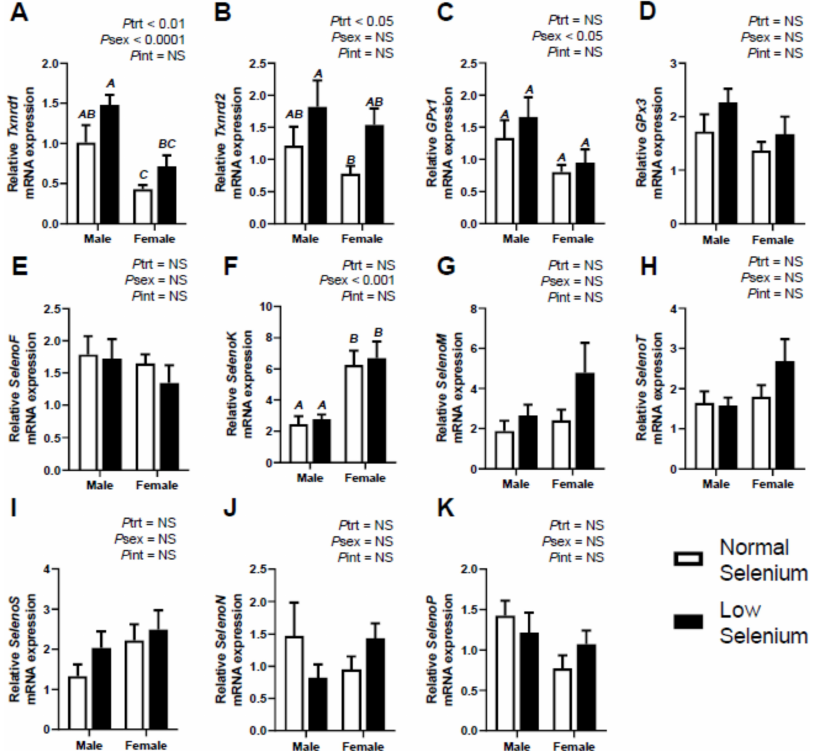
Figure 5. E ff ects of selenium deficiency on selenoprotein expression in o ff spring kidneys at PN180. Expression in male and female o ff spring kidneys, at PN180, of; ( A ) thioredoxin reductase 1, ( B ) thioredoxin reductase 2, ( C ) glutathione peroxidase 1, ( D ) glutathione peroxidase 3, ( E ) selenoprotein F, ( F ) selenoprotein K, ( G ) selenoprotein M, ( H ) selenoprotein T, ( I ) selenoprotein S, ( J ) selenoprotein N and ( K ) selenoprotein P. Data are mean ± SEM and analysed by two-way ANOVA with treatment ( P trt ) and sex ( P sex ) as major factors. P int represents the interaction between treatment and sex. Significance was determined as p < 0.05. If a major effect of treatment, sex or an interaction between treatment and sex was identified, then a Sidak posthoc test was performed. Significant differences between groups as detected by posthoc analysis are denoted by different letters where “A” is different from “B” which is different from “C”. “A” is not different from “A” or “AB”, while “B” is not different from “B”, “AB” or “BC”. The groups are Normal male, n = 8 (8 animals from 8 separate litters); Low male, n = 8 (from 8 separate litters); Normal female, n = 8 (from 8 separate litters); Low female, n = 6 (from 6 separate litters). Maternal selenium deficiency led to a reduction ( P trt < 0.05) in SelenoP expression within